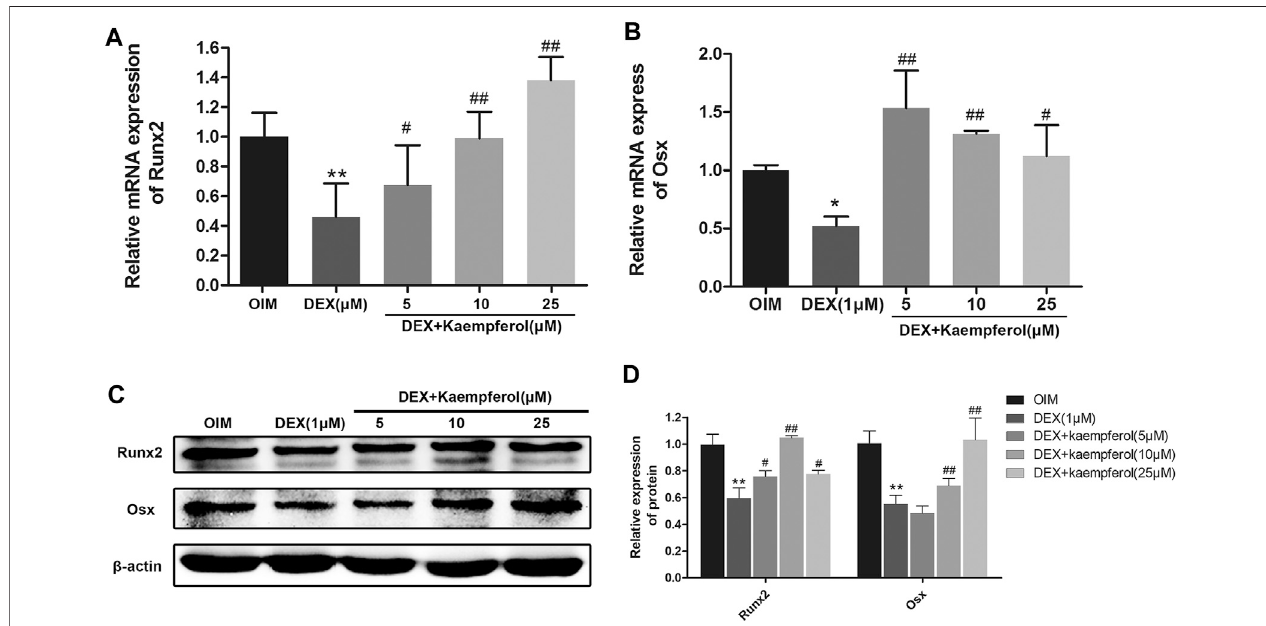
FIGURE 7 | The effect of kaempferol on Runx2 and Osx expression in DEX-treated MC3T3-E1 cells. The mRNA expression of Runx2 (A) and Osx (B) were analyzed by qRT-PCR. (C) The expression of Runx2 and Osx were detected by western blot. (D) The quanti fi cation of Runx2 and Osx was indicated. * p < 0.01, ** p <